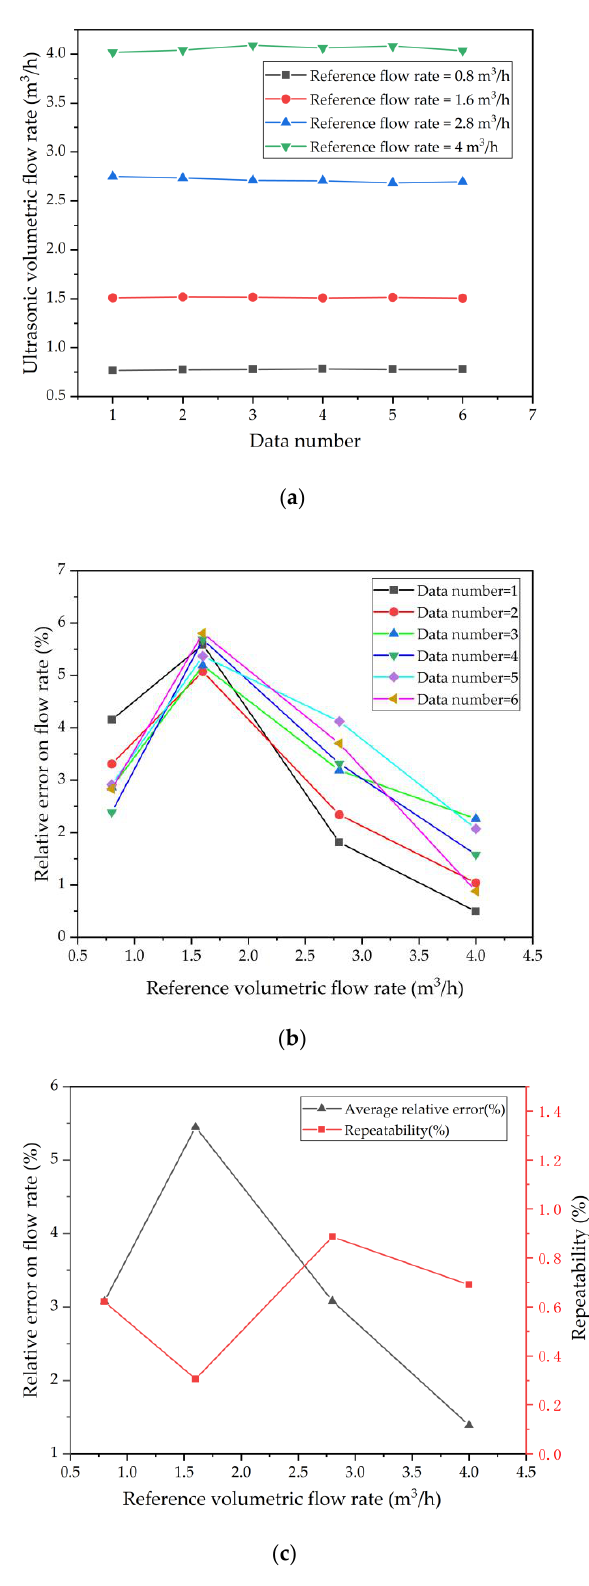
Figure 14. ( a ) The ultrasonic volumetric flow rate after calibration using k c = 0.93. ( b ) Relative errors on the ultrasonic volumetric flow versus the reference flow rates. ( c ) Average relative error of six measurements and repeatability error.